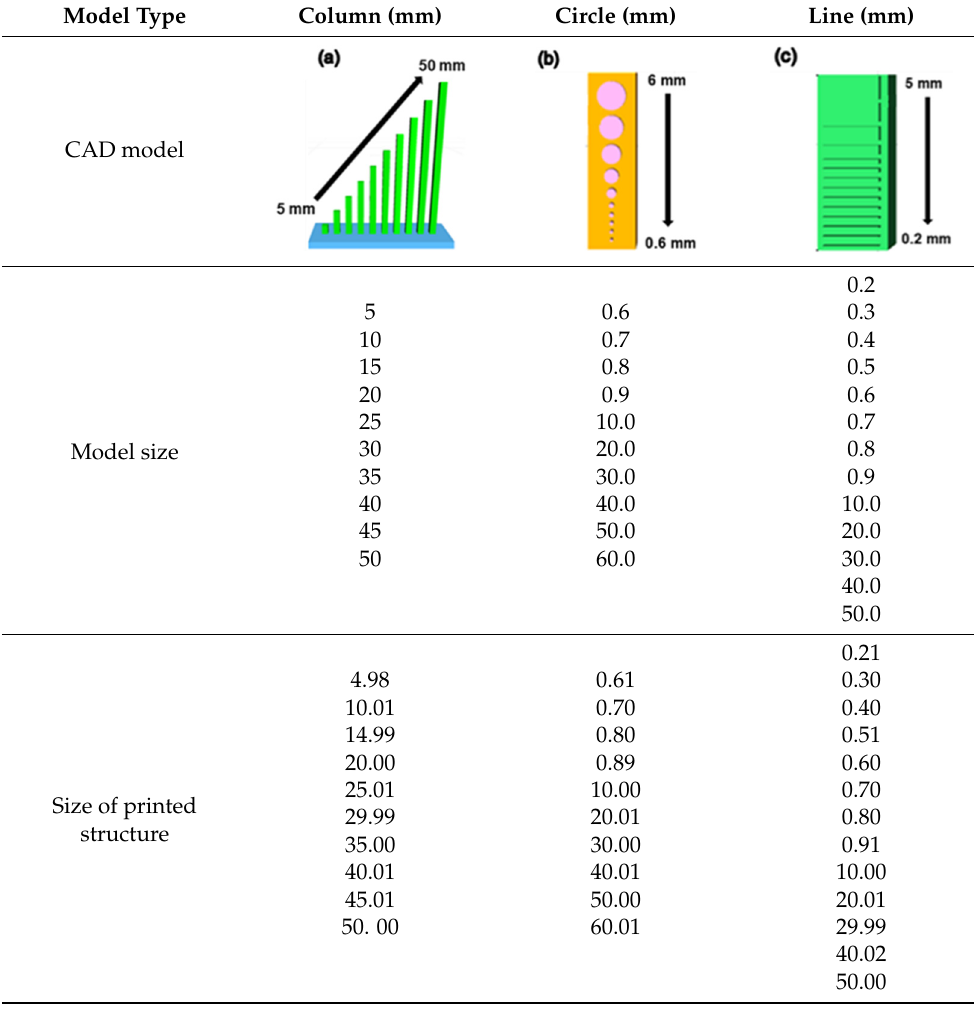
Table 6. Pigment ratio of urethane acrylate resin. Resin (Color) *